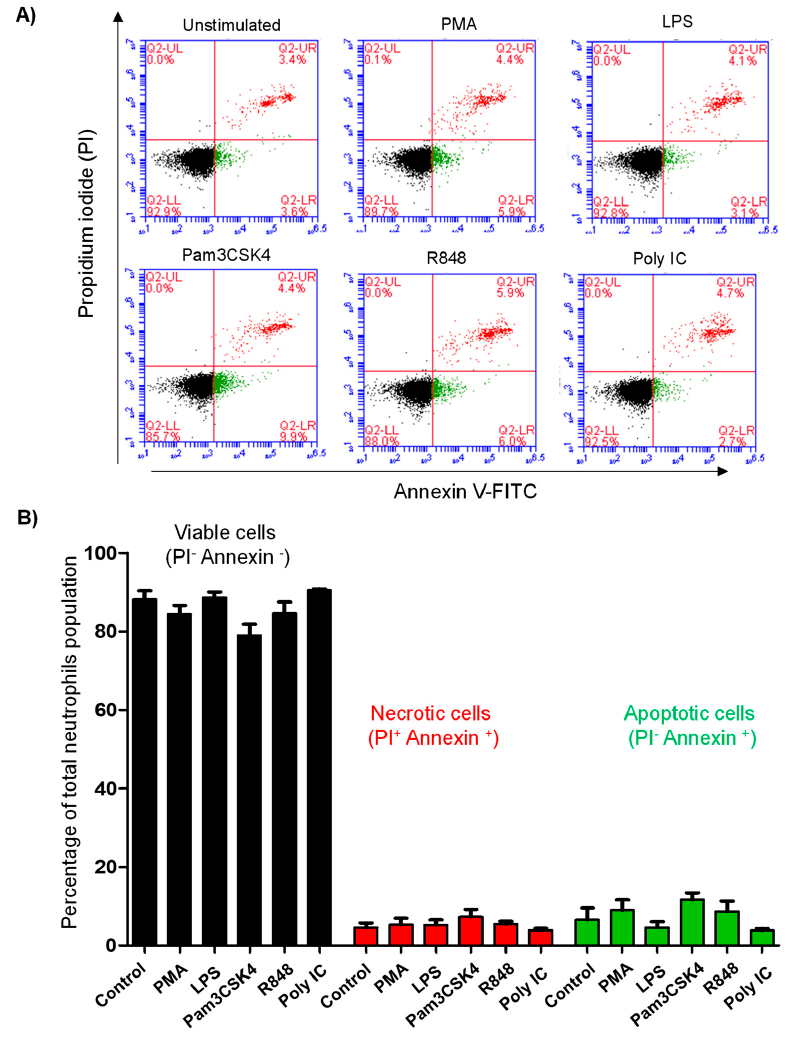
Figure 5. Flow cytometric analysis of cell vitality of camel neutrophils. Control and stimulated neutrophils were labeled with the cell apoptosis dye annexin V-FITC and the cell necrosis dye propidium iodide (PI) and analyzed by flow cytometry. ( A ) Representative dot plots of annexin V-FITC against PI fluorescence showing the identification of necrotic (PI + /annexin V + ), apoptotic (PI − /annexin V + ), and live neutrophils (PI - /annexin V − ) upon excitation at 488 nm. ( B) The percentage of necrotic, apoptotic, and viable neutrophils was calculated and presented as mean ± SEM. * indicates significant change in the FSC-A between the means of stimulated and non-stimulated cells with p values less than 0.05.